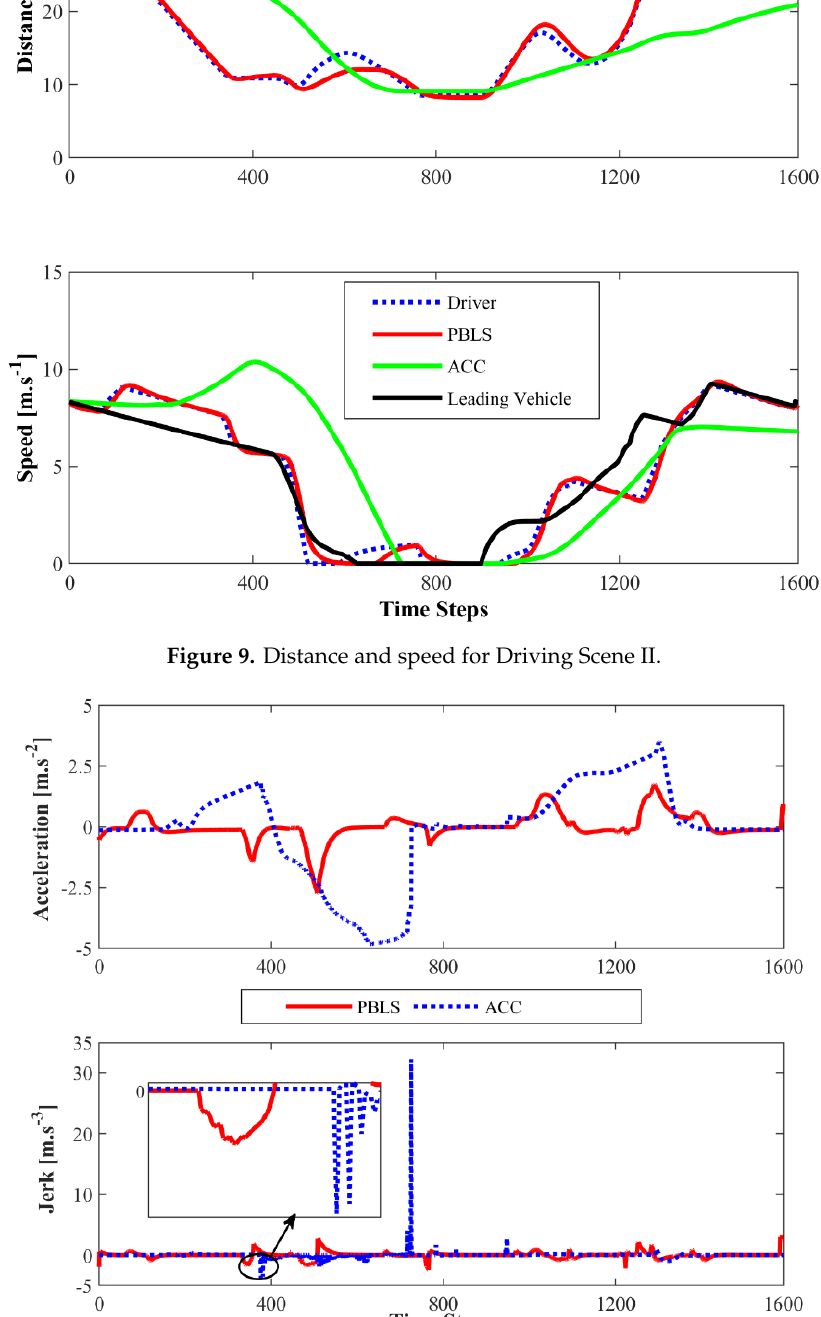
Figure 11. RMSE in different scenes. Figure 12. Comfort measurement ( J 1 ) for different systems in different scenes. 5.3. Driving Scene III In the third driving scene, as shown in Figure 13, two real vehicles are involved for collecting the real driving data. The Beijing Institute of Technology (BIT) intelligent vehicle [37] is used as the host vehicle in this work. This vehicle is equipped with on-board sensing systems to capture the